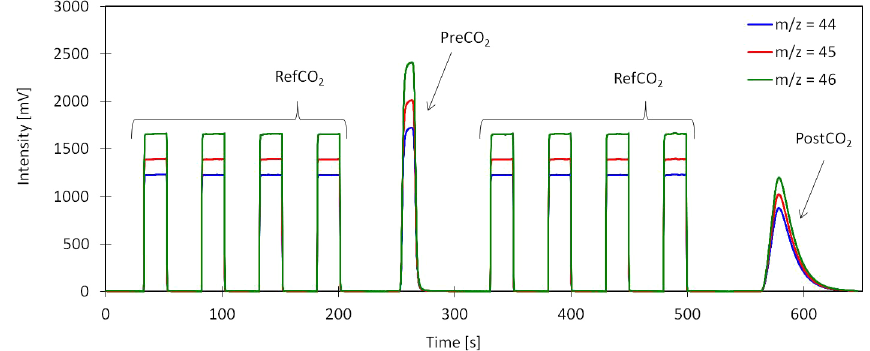
Figure 4. Example of a typical IRMS chromatogram of a single (cid:49) 17 O(CO 2 ) analysis with the CF-IRMS system described here. The eight square peaks are the working reference CO 2 (RefCO 2 ) peaks injected directly via the open split interface. The non-equilibrated CO 2 (PreCO 2 ) peak and the equilibrated CO 2 (PostCO 2 ) peak are the two sample gas